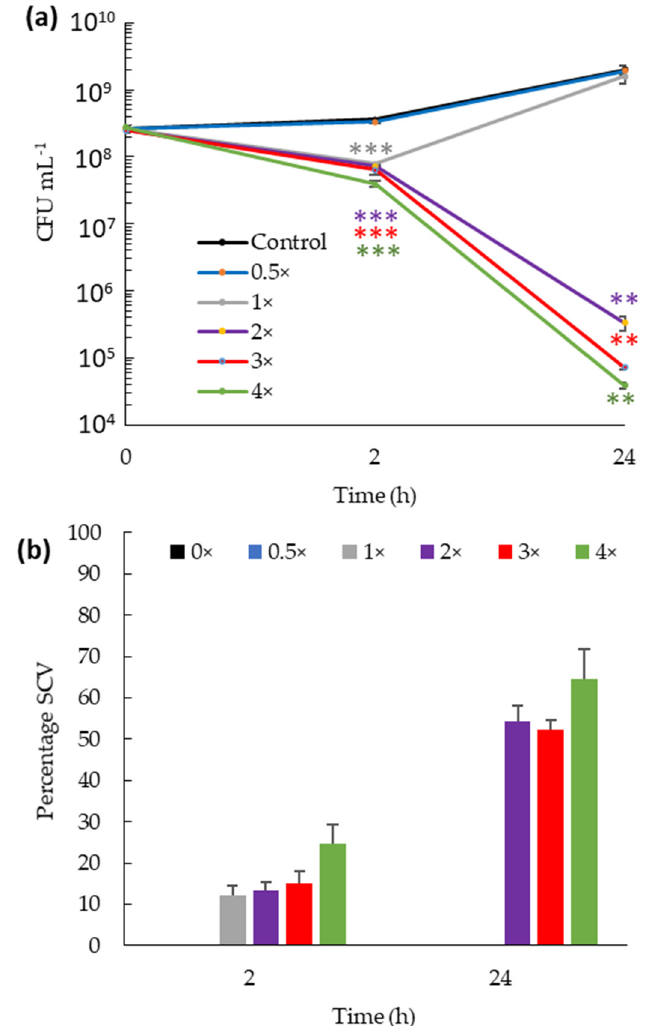
Figure 2. Time-kill kinetics of Spg-A against MRSA at different concentrations. ( a ) Log reduction in bacterial counts after 2 and 24 h of treatment with different MIC. ( b ) Percentage of small colony variants present in the Spg-A treated culture with different MIC at 2 and 24 h. Exponential phase bacteria were incubated in MHB with the indicated concentrations of Spg-A (0.5 to 4 × MIC) and in its absence (control). Bacteria were serially diluted and plated at every time point onto BHI agar and incubated overnight. Total number of colonies and number of small colony variants (SCV) for each dilution were counted to calculate CFU mL − 1 . No SCV were detected at 0, 0.5, and 1 × MIC. Data presented are the averages of three experiments performed in duplicate. Error bars represent standard deviation. p -values were calculated by the Student’s T-test comparing the treated bacteria with the untreated control at each time point (** = p < 0.01; *** = p < 0.001). Time-kill kinetic analysis of bis-indole Spg-A against V. parahaemolyticus was also performed (Figure 4). Two-, 3-, and 4-fold log reductions with 4 × MIC was observed in viable V. parahaemolyticus after just 15, 30, and 45 min of incubation, respectively. Moreover, no viable bacteria were detected after 1 h of